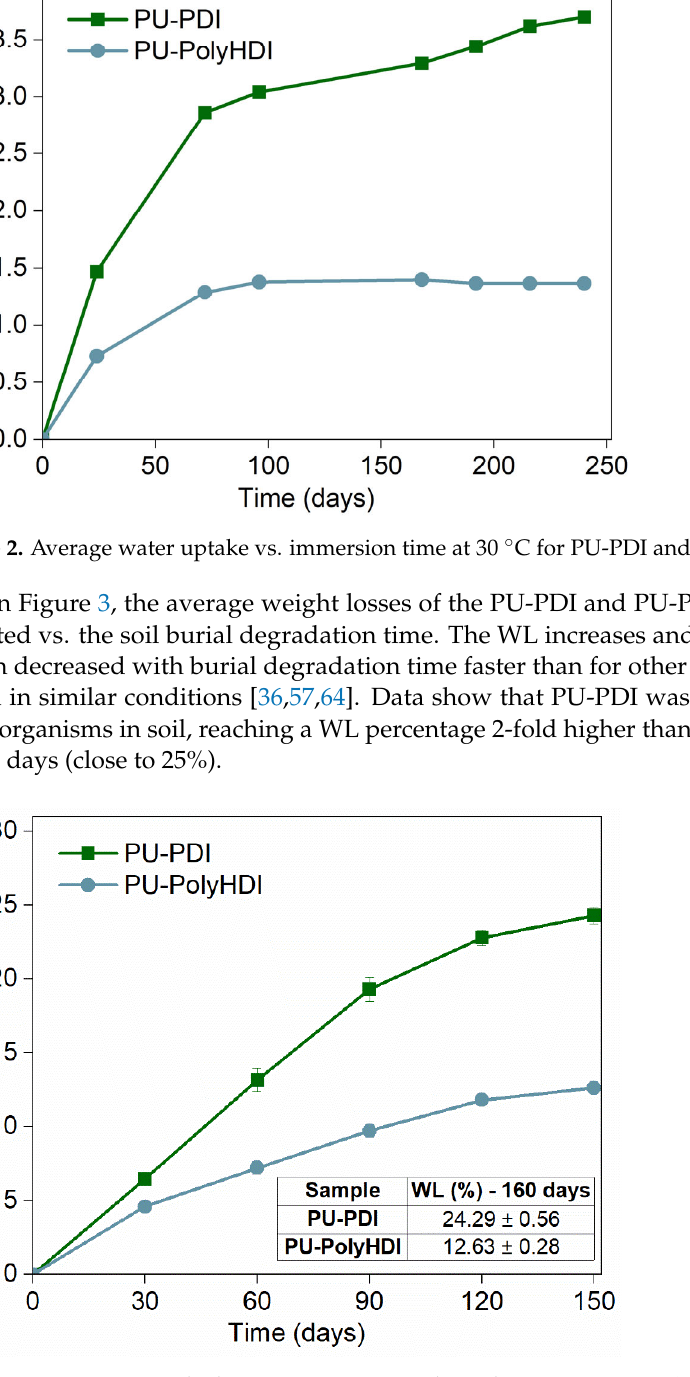
Figure 3. Average weight loss percentage vs. degradation time at 30 °C for PU ‐ PDI and PU ‐ PolyHDI samples.